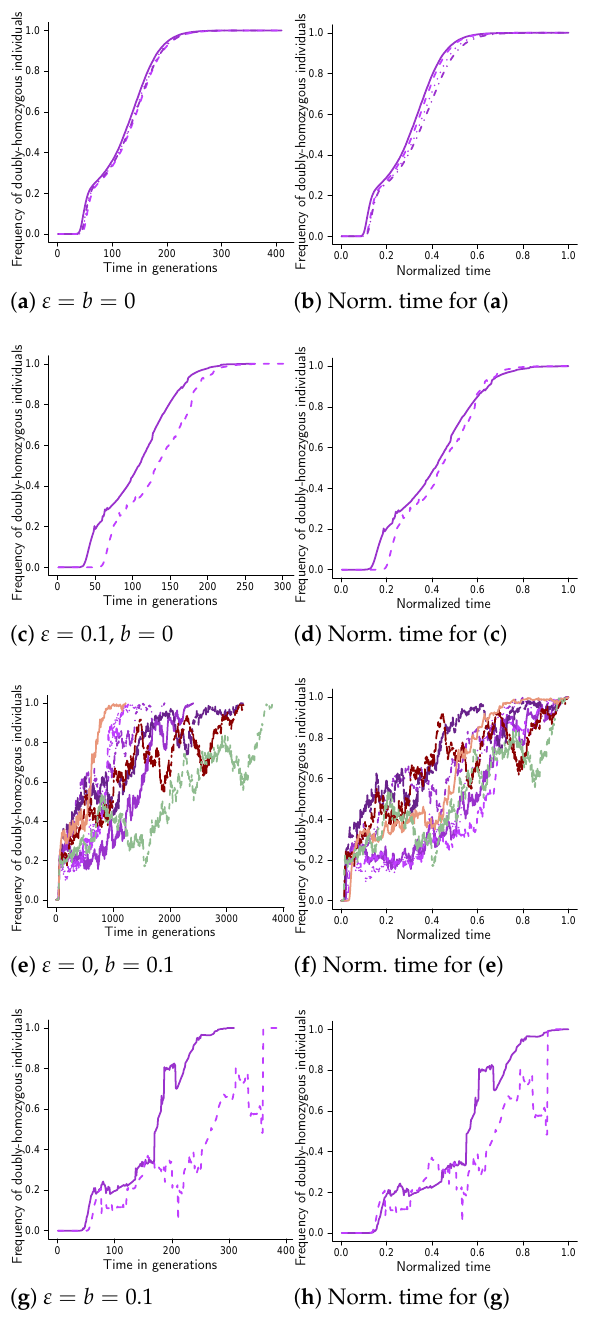
Figure A4. Two sites with weight function as in Equation (A4). Examples of excursions to fixation at two sites with weight function as given by Equation (A4) for carrying capacity C = 10 6 , cutoff u ( N ) = C , probability of recombination r = 0.25 between adjacent sites, α 1 = 0.75, α 2 = 3, ε (see Equation (7)) and probability of a bottleneck b as shown, strength of selection s = 0.1 and bottleneck B = 10 3 ; results from ten experiments for ( a , c ); otherwise, from 10 2 experiments. Each trajectory traces, as a function of time, the number of diploid individuals homozygous for the fit type at all sites relative to the population size (the number of diploid individuals). The panels on the right ( b , d , f , h ) show the corresponding excursions from the left panels ( a , c , e , g ), where the time to fixation for each excursion is normalized by the time to fixation for the excursion. The scale of the abscissa (time axis) may vary between panels; in each panel, the trajectories were all obtained under identical